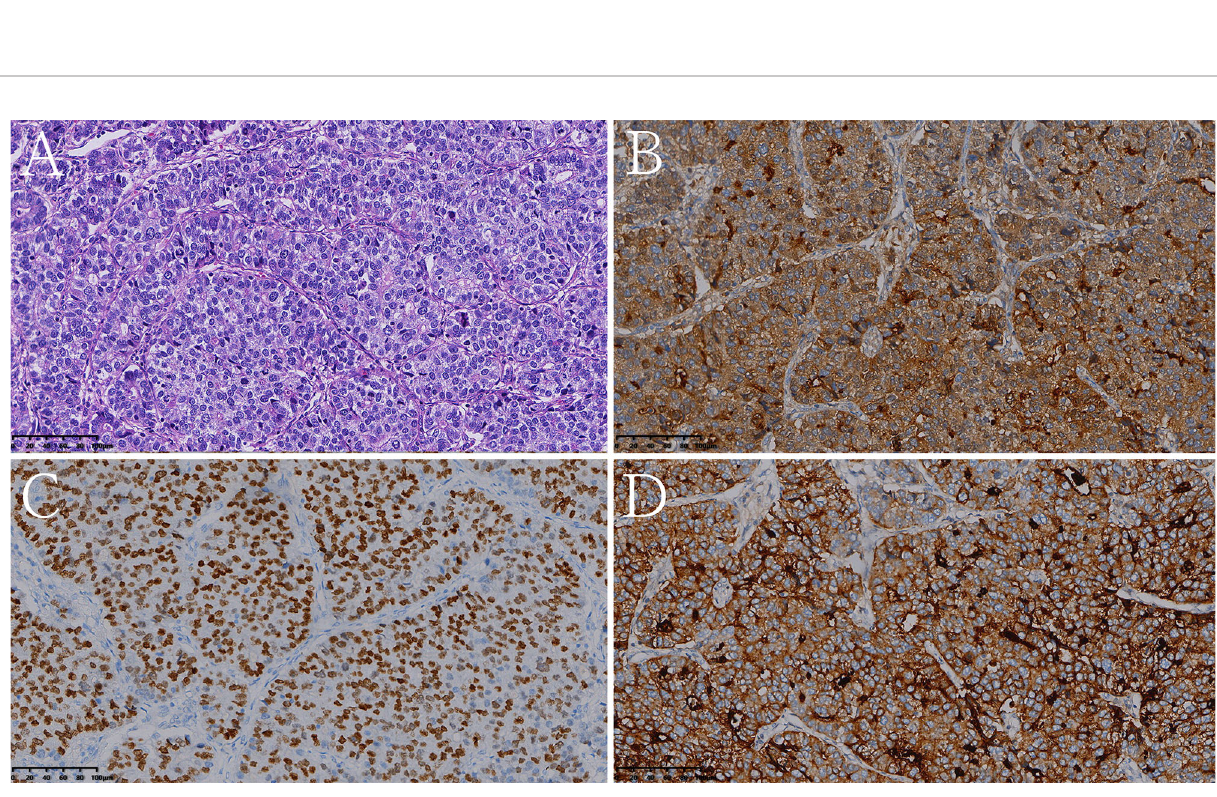
Frontiers in Oncology |